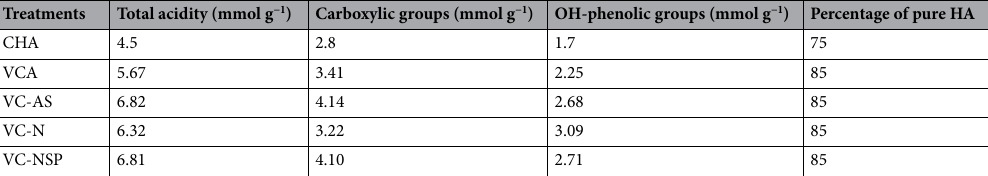
Table 2. The average comparison table related to the results of the effect of different enrichment treatments on the values of functional groups in HA.